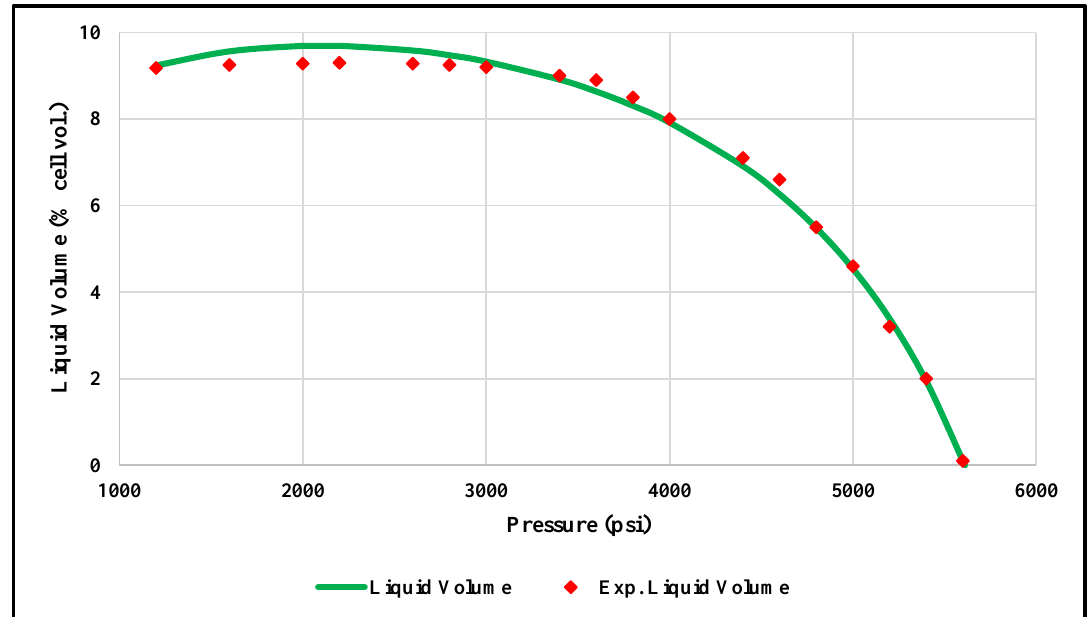
Figure 11. Two-phase diagram for the gas condensate reservoir under consideration. The straight line indicates the assumed isothermal pressure depletion program.